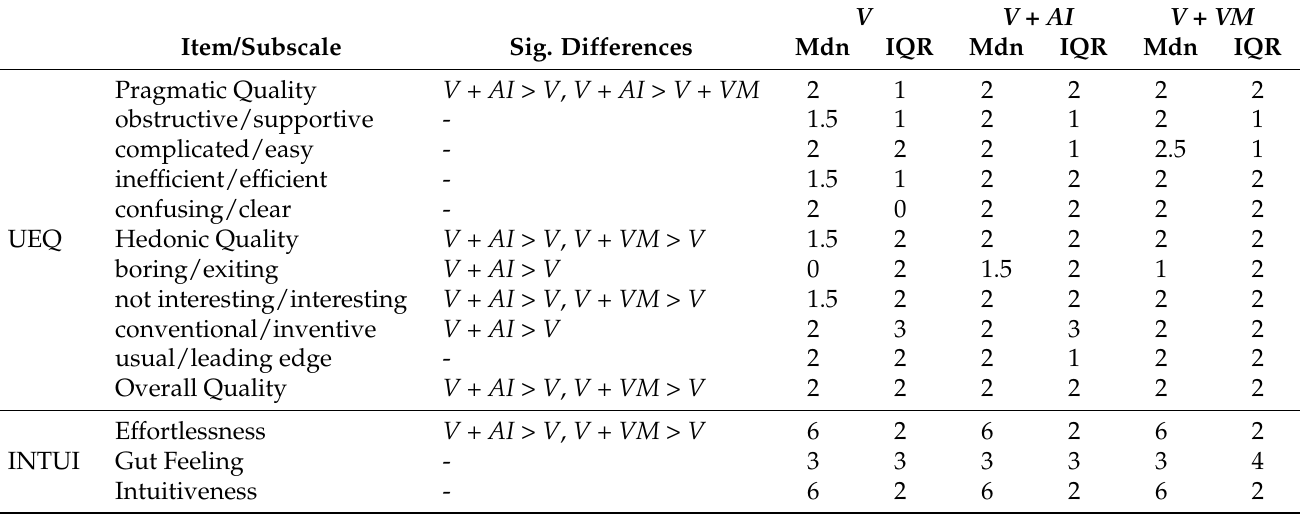
Table 4. Median and Interquartile Range for UEQ and INTUI items and/or subscales. We further added the relations of the conditions where the items/subscales were rated significantly